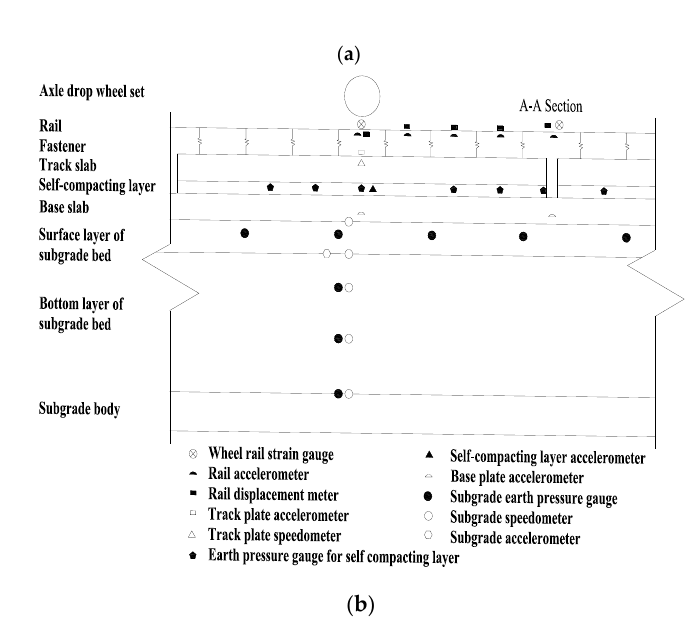
Figure 13. Sensor layout diagram: ( a ) plan view; ( b ) front view.